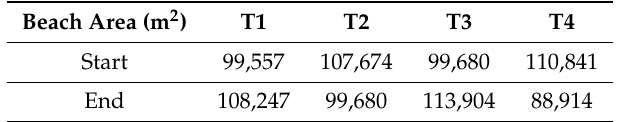
Table 2. Beach area measured at the start and end dates of the four selected periods.